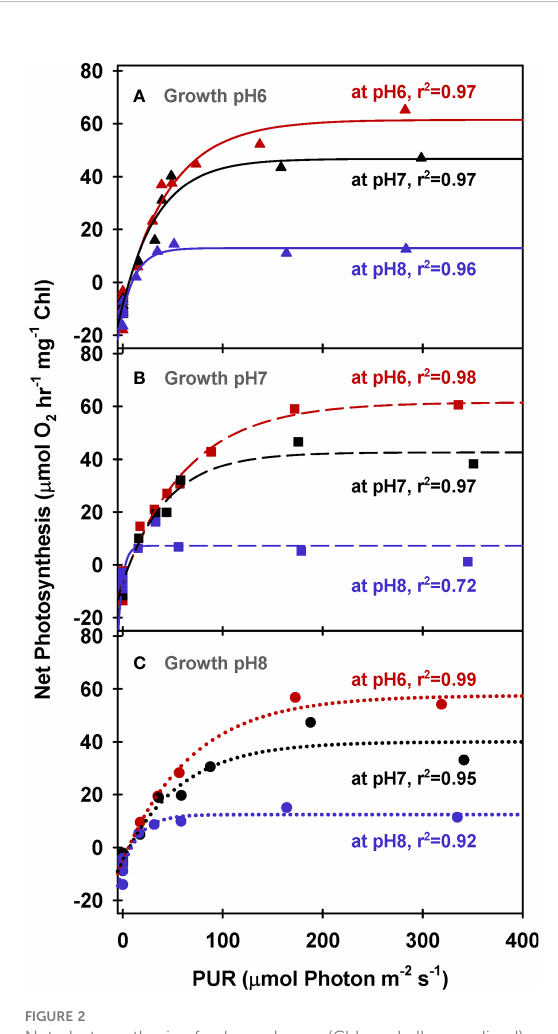
FIGURE 3 FIGURE 2 Modeled gross photosynthesis (A) and photorespiration (B, C) of Net photosynthesis of eelgrass leaves (Chlorophyll normalized) eelgrass leaves as a function of absorbed irradiance. Colors as a function of absorbed irradiance. O 2 production rates were represent different pH/CO 2 levels at which the measurements measured at different pH levels (red: pH6, black: pH7 and blue: (M pH ) were performed; line styles represent the different pH/CO 2 pH8) using leaves grown at pH6 (2121 µ M CO 2(aq) ) (A) , pH7 (371 levels at which the plants were grown (G pH ). Photorespiration at µ M CO µ M CO 2(aq) ) (B) and ambient pH8 (55 2(aq) ) (C) . Curves M pH6 were were fi t using Equation (2).